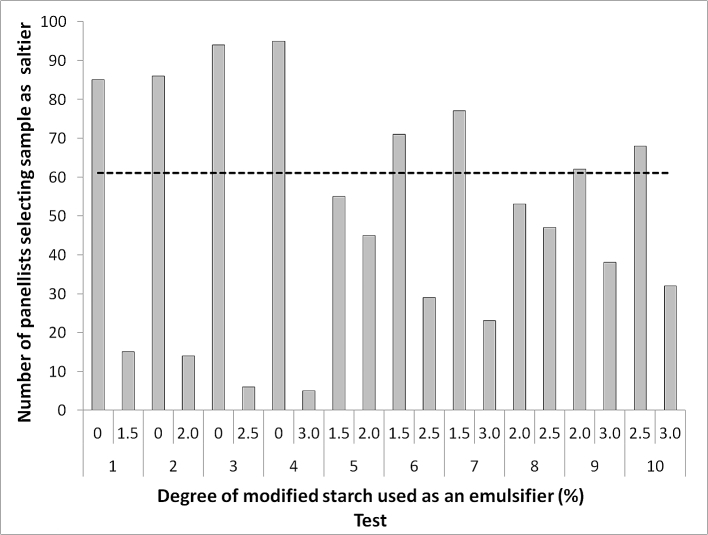
Sample pairs presented in the paired comparison test of emulsions stabilised with five different degrees of OSA-starch modification. The dotted line indicates the minimum number of consensual responses required to conclude significant difference (α = 0.05).